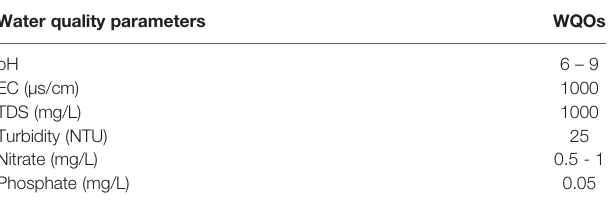
TABLE 1 | Water quality objective used in this assessment according to Chinese Environmental Protection Agency, 2002 (GB3838-2002). Water quality